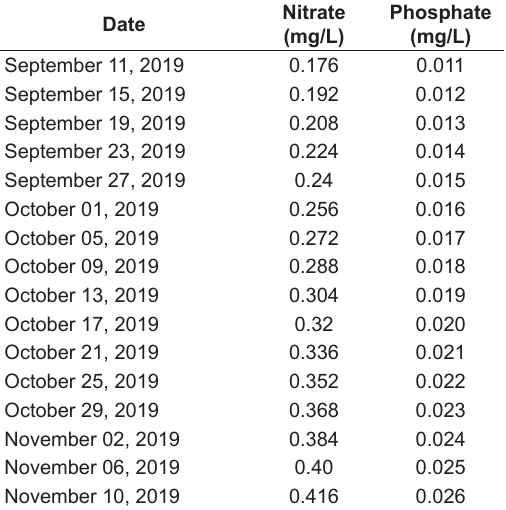
Table 1. Nitrate and phosphate concentrations added to promote eutrophication of E and F mesocosms. The additions were maintained during the interview period (October 29, 2019 to November 12, 2019) seeking to maintain blooming.